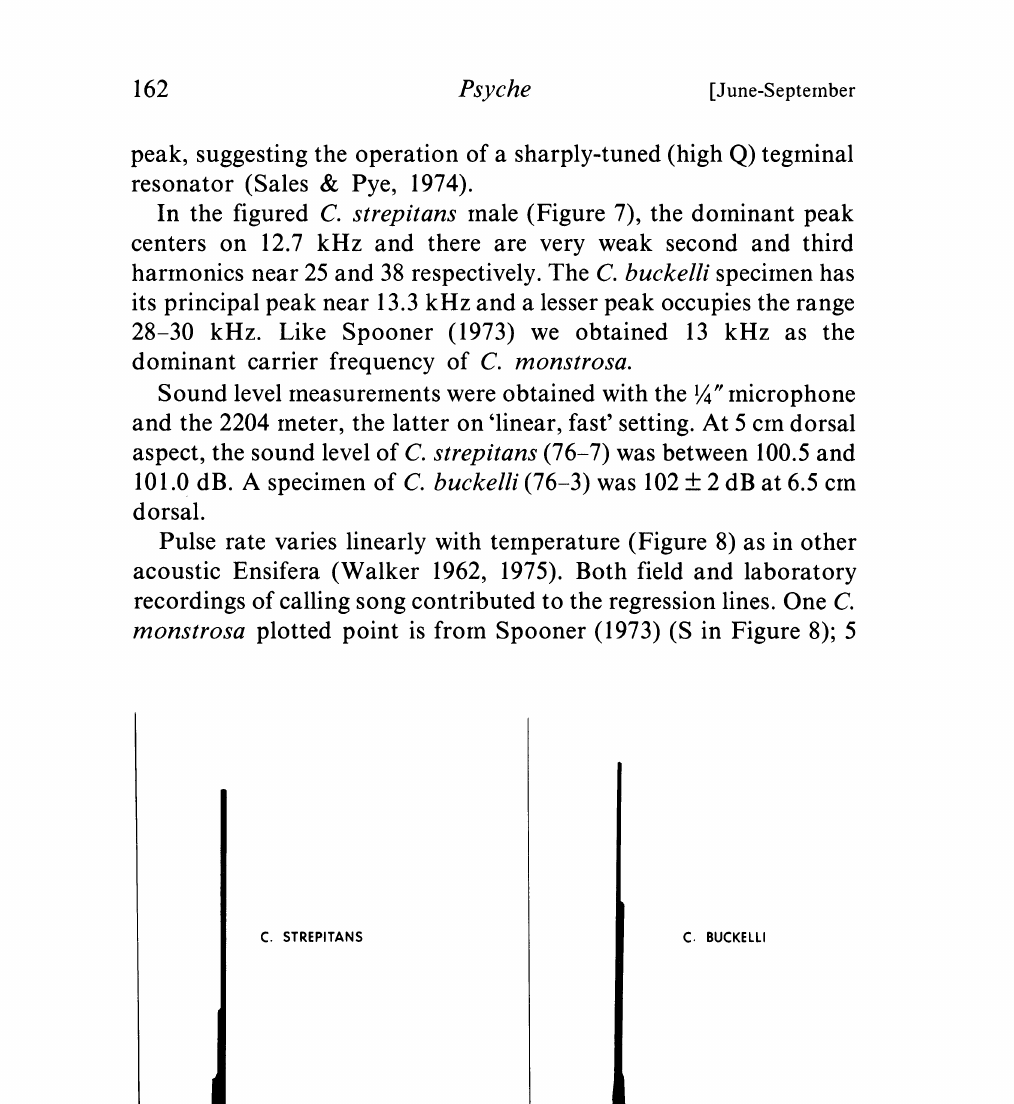
Figure 7. Calling song frequency spectrograms traced from